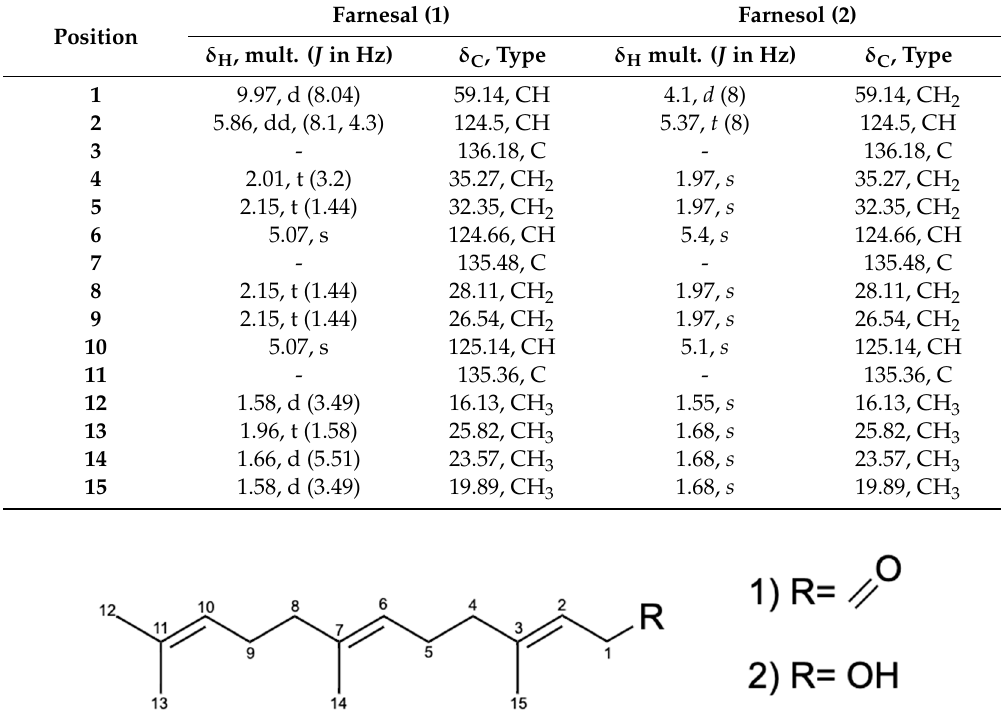
Figure 5. Structures of the compounds farnesal ( 1) and farnesol ( 2 ) isolated from A. diversifolia .